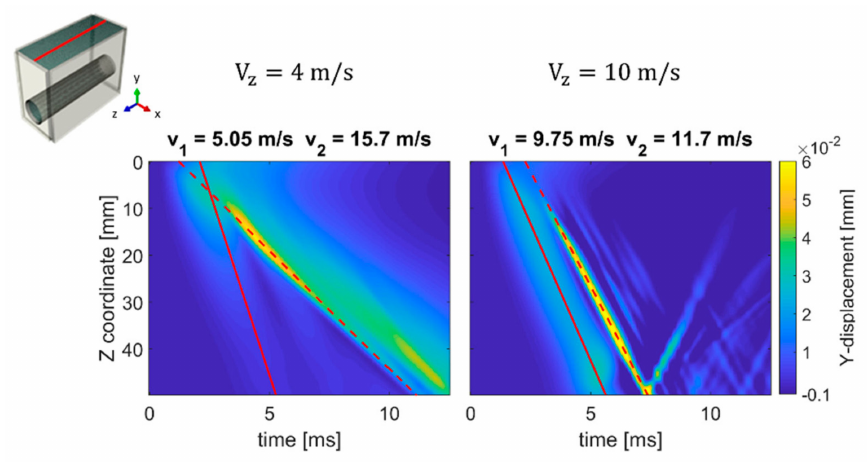
Figure 6. TOF plots at the skin surface for a traveling impulse propagating with a velocity V z of 4 and 10 m / s. The text above each plot indicates the propagation velocity of the main wave front (V 1 ), marked by the red dashed line, and the speed of the secondary wave front (V 2 ), indicated by the solid